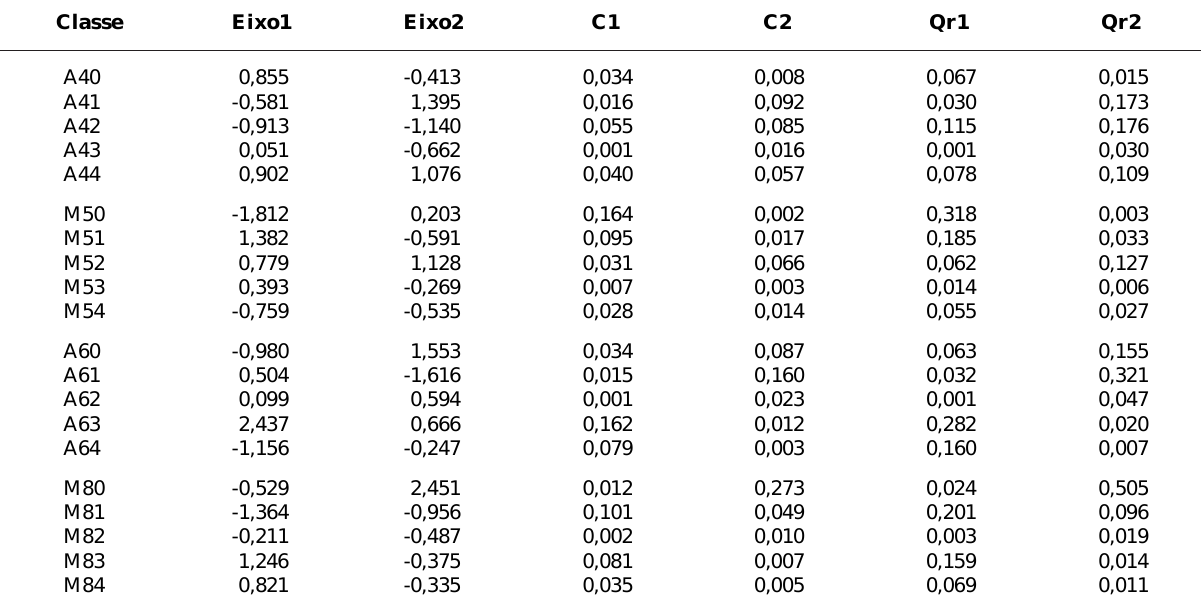
Eixo 1 e Eixo 2 referem-se, respectivamente, à decomposição da inércia para o primeiro e segundo eixo; C1 e C2 referem-se, respec- tivamente, aos pontos que melhor explicam a inércia para o primeiro e segundo eixo; Qr1 e Qr2 referem-se, respectivamente, à qualidade de representação dos pontos para o primeiro e segundo eixo.